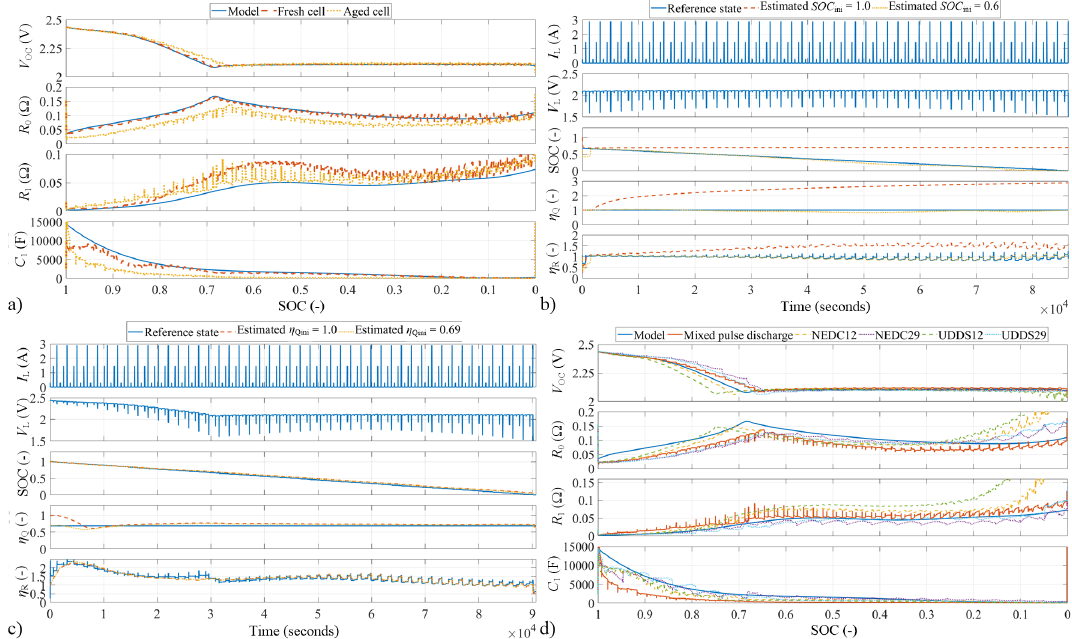
Figure 4. ( a ) comparison of the battery model and online identified parameters for the fresh and aged cell. It shows that, when the cell ages, the inflection point between the high and low voltage plateaus is moving to the right (to lower SOC); ( b ) the mixed pulse discharge test profile and the estimated results for the fresh cell, when the discharge starts already at the low voltage plateau. If the SOC ini is also at the low voltage plateau, the state converges, otherwise they do not; ( c ) the mixed pulse discharge test profile and the estimated results for the aged cell. The estimates converge for all states. The accuracy is higher with the initial estimate closer to the reference state; ( d ) battery model identified parameters for the aged cell at various mission profiles. The absolute available capacity obtained during the discharge causes the shifting of the inflection point at the V OC and R 0 curves due to the SOC relativity to the available capacity. At the end of the discharge, there is a rapid increase of the resistance, dependent on the current rate and the dynamic of the mission